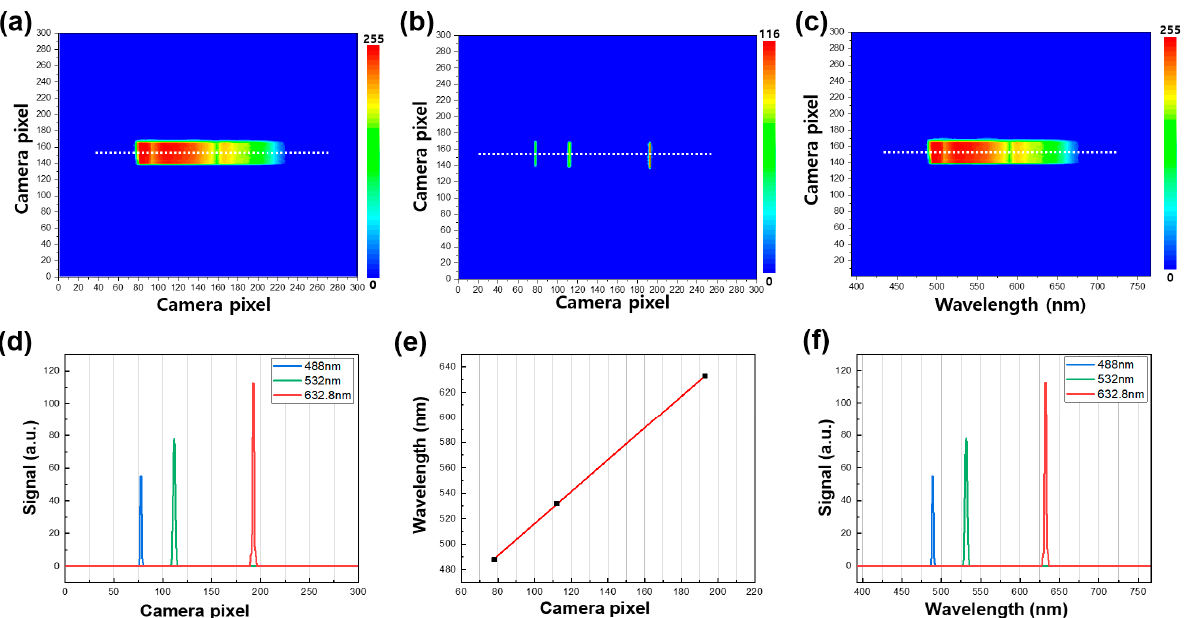
Figure 2. ( a ) A representative contour map of the broadband light source in the wavelength range of 500 nm to 680 nm. ( b ) A representative contour map combining three different emission signals was obtained by using the three laser line filters (488 nm, 532 nm, and 632.8 nm, left to right). ( c ) A representative contour map of the broadband light source after the wavelength conversion process. ( d ) Emission spectra of the white line in ( b ). ( e ) Correlation of the X camera pixel with wavelength. ( f ) Emission spectra of the white line in ( b ) after the wavelength conversion process.